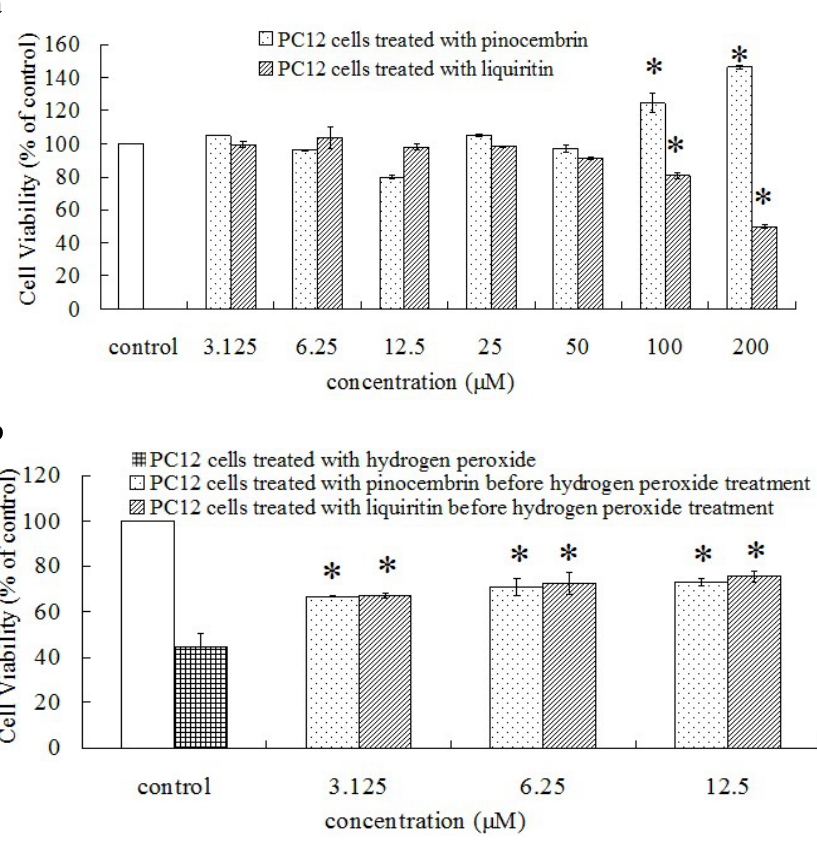
O -injured PC 12 cells. □ , negative control group without 2 2 O -injured group without 2 2